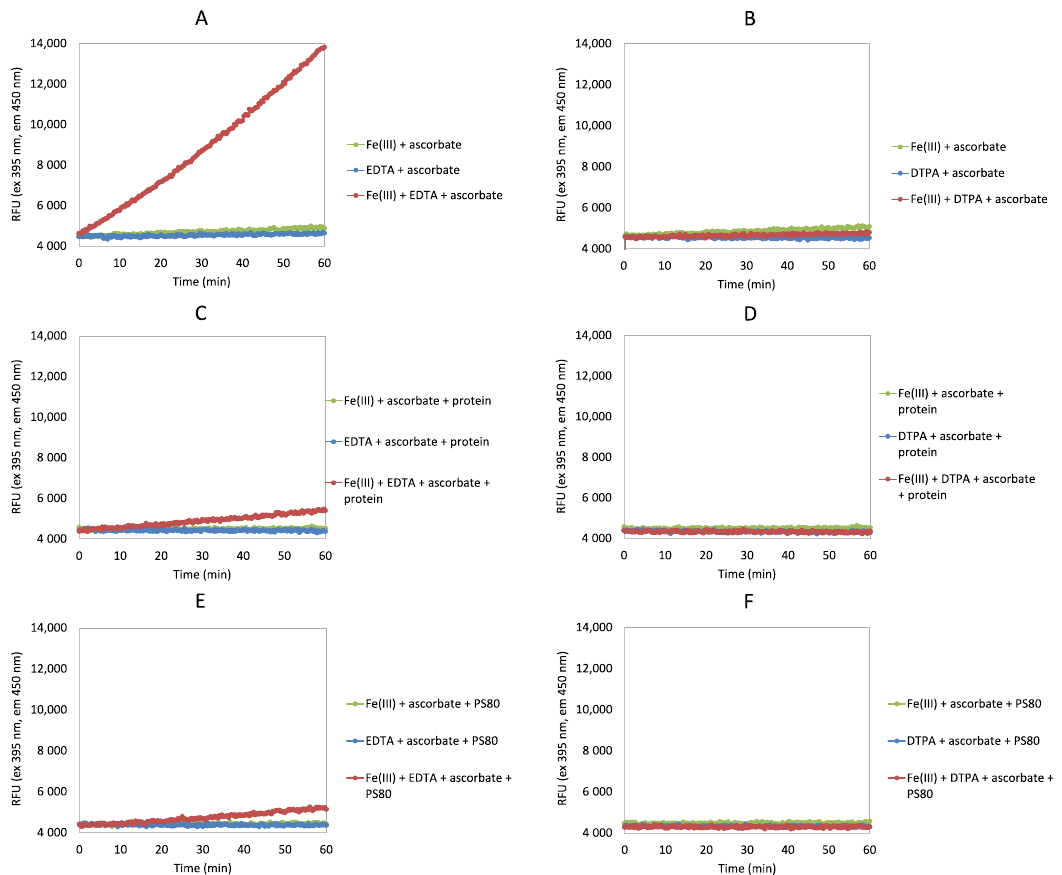
Figure 2. Time courses of the production of • OH (RFU, relative fluorescence units) during autooxidation of Fe(III) complexes measured according to the fluorescence intensities of 7-hydroxy-coumarine-3-carboxylic acid after incubations of CCA with ascorbate ± Fe(III), and ± ethylenediaminetetraacetic acid (EDTA) ( A , C , E ) or ± diethylenetriaminepentaacetic acid (DTPA) ( B , D , F ), and plus protein ( C , D ) or plus PS80 ( E , F ). Positive control, ascorbate and Fe(III), and plus protein ( C , D ) or plus PS80 ( E,F ); negative control, ascorbate plus chelating agent (EDTA / DTPA) or antioxidant (quercetin / GSH), and plus protein ( C,D ) or plus PS80 ( E,F ); see also Figures S1, S3 and S5. All solutions were prepared in 20 mM KH 2 PO 4 , 1 µ M desferrioxamine, pH 7.4, except FeCl 3 (ultrapure water).